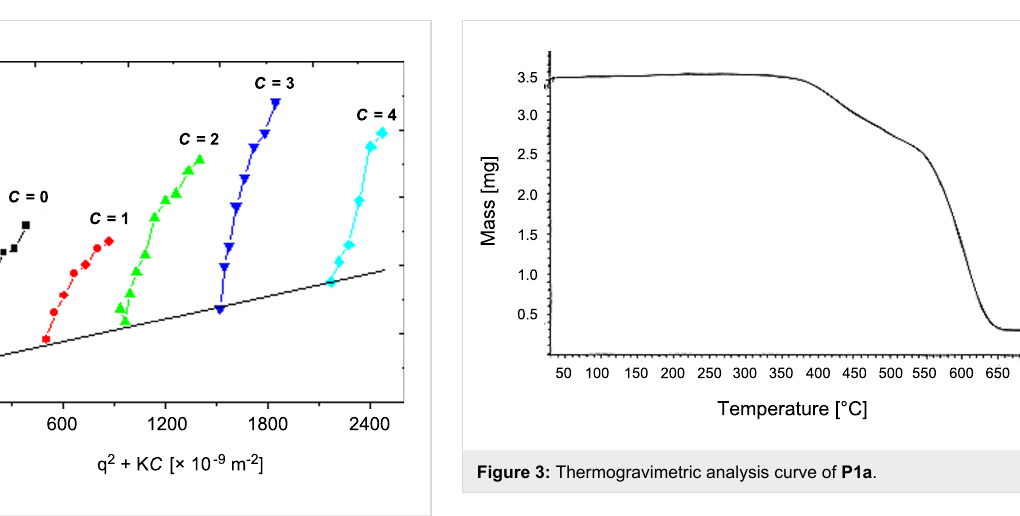
Figure 2: Zimm plot for P2a in THF at room temperature. rate of 80 mL/min. Polymers P1 and P2 lost weight gradually during the early phase of the experiment. A thermal gravi- metric analysis curve of P1a is shown in Figure 3. The thermal analysis results indicated that polymers P1 and P2 have a high decomposition temperature T d and good thermal stability above 300 °C, which is very attractive for the fabrica- tion of stable organic electroluminescent devices. TGA thermo-